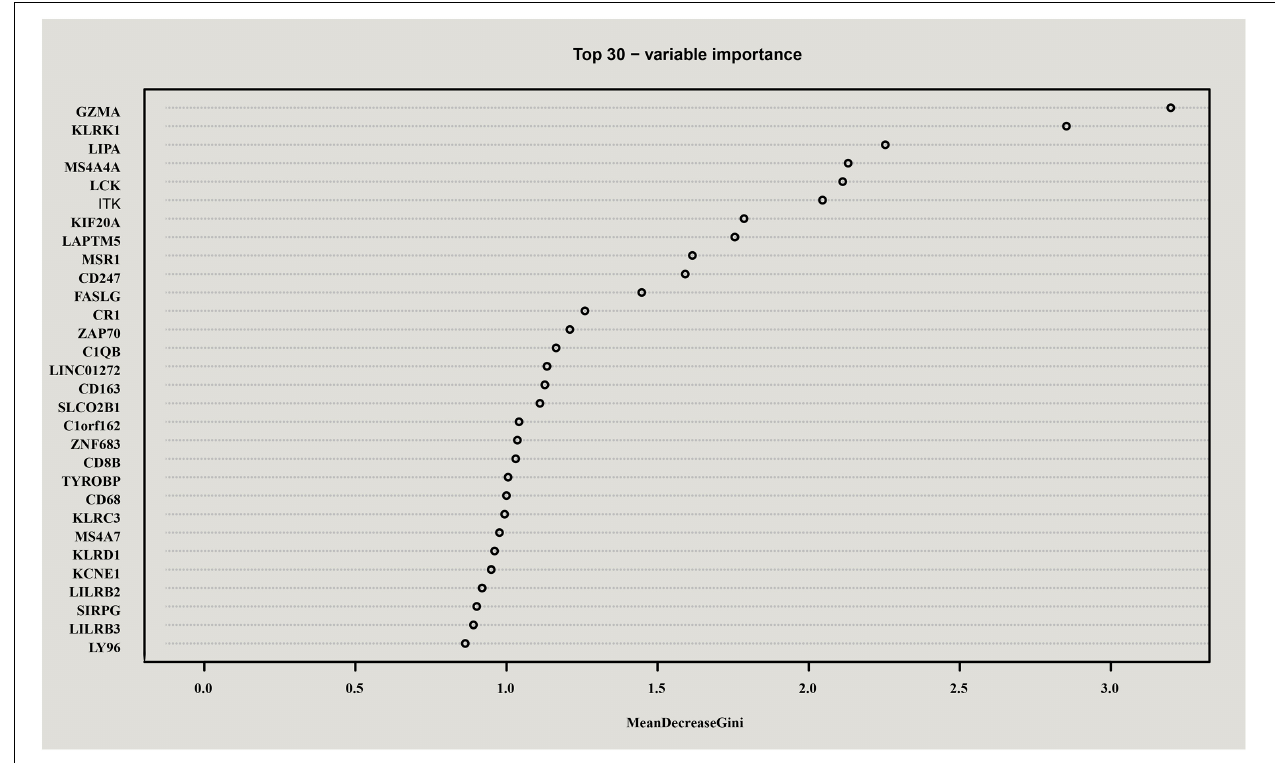
FIGURE 3 | Top 30 genes in random forest scoring results. All genes were sorted in descending order according to Mean decrease gini (MDG), and the top 30 candidate genes for radiotherapy resistance in cervical cancer were